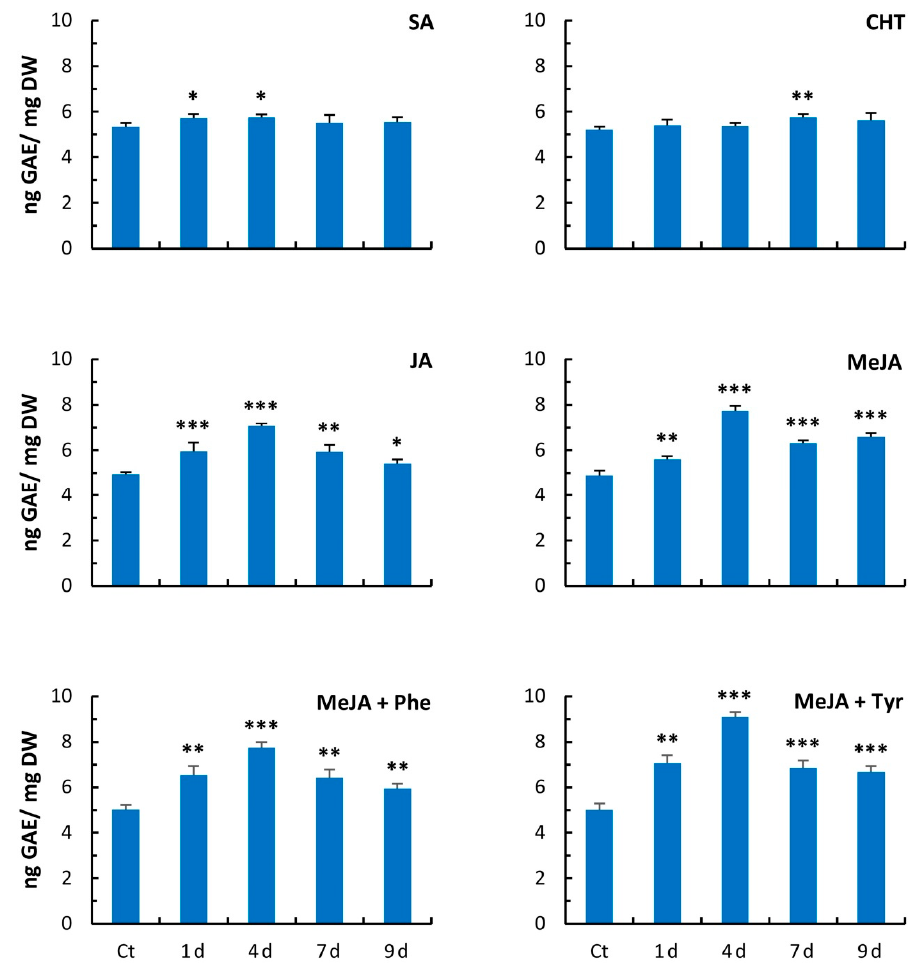
Figure 2. Total phenolic accumulation in hemp suspension cultures during nine days of elicitation.